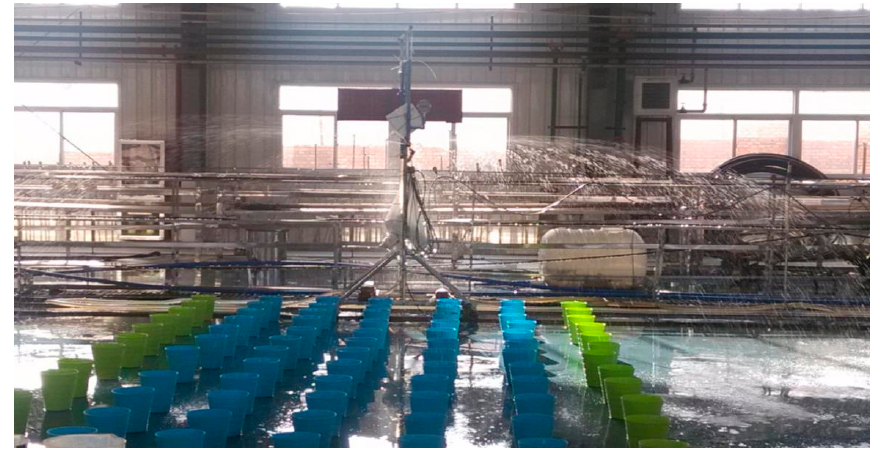
Figure 8. Experimental setup to determine the water distribution pattern from a sprinkler in lateral